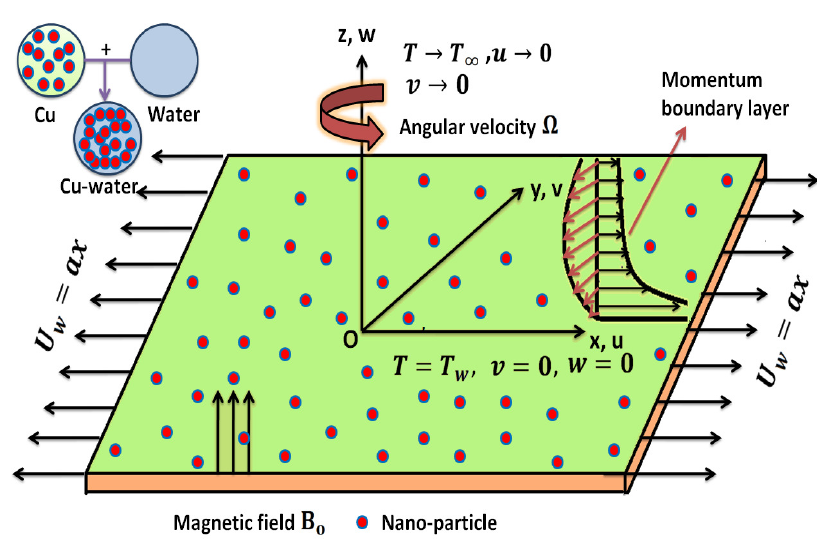
Figure 1. Geometric configuration and coordinate